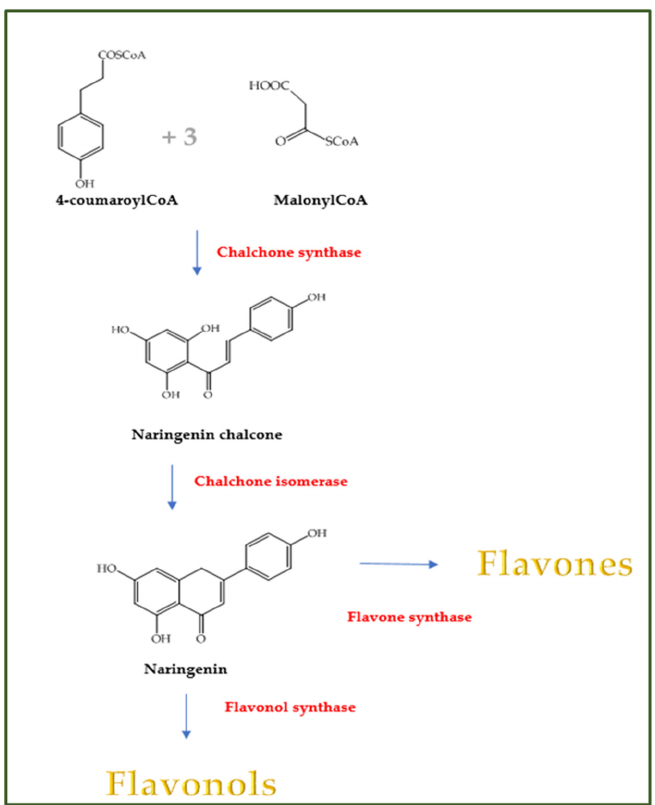
Figure 6. Flavonoid’s biosynthesis [66].